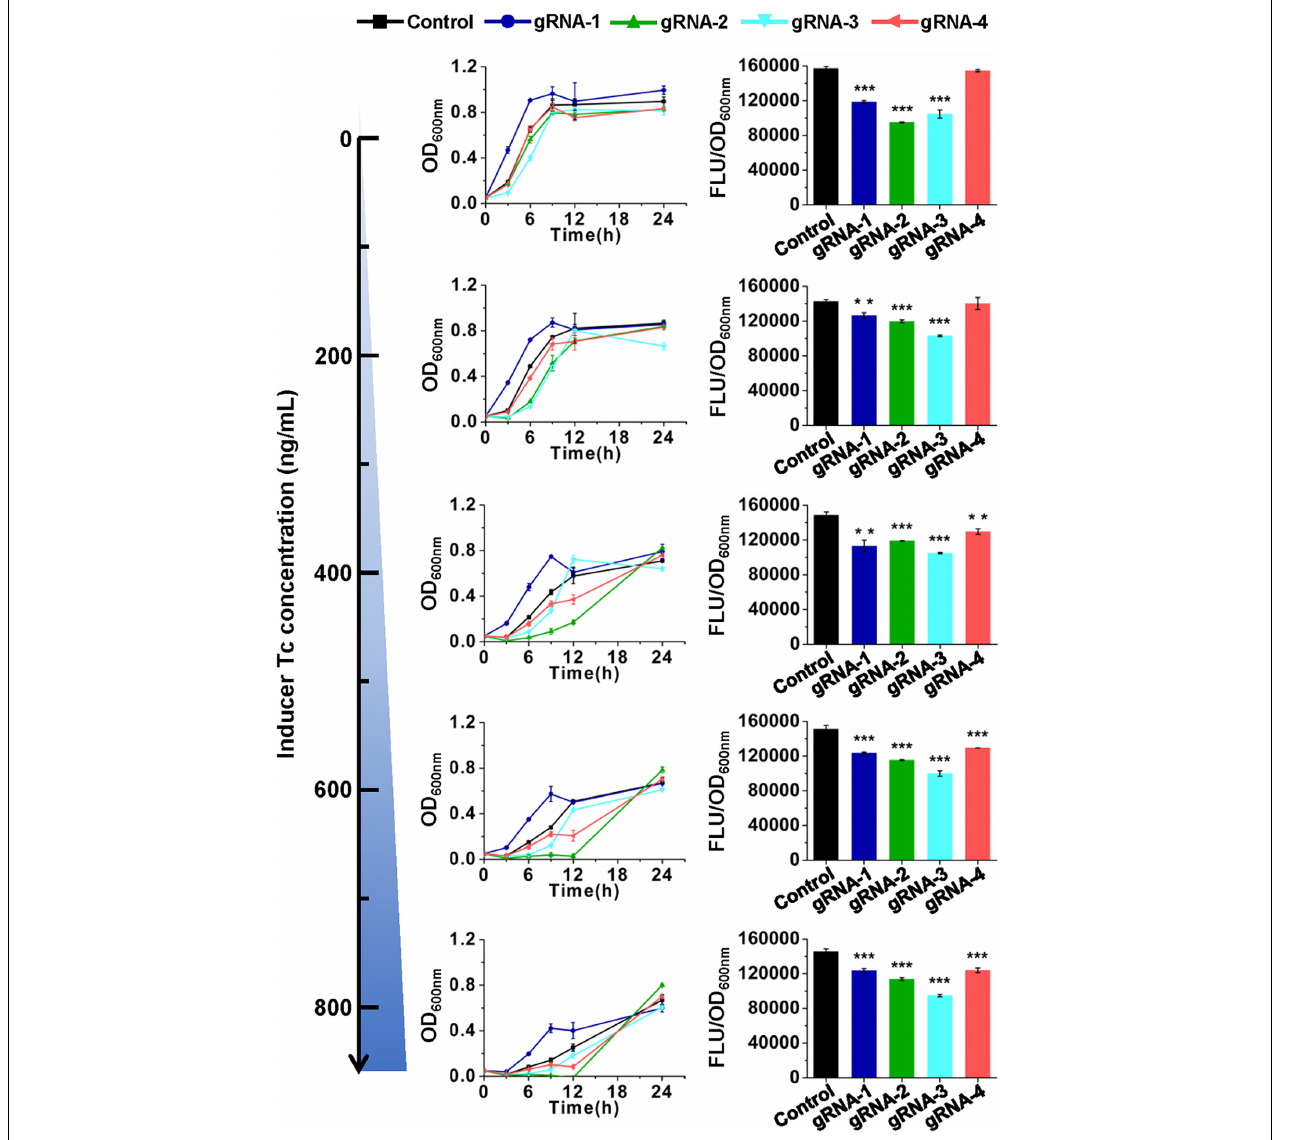
FIGURE 2 | CRISPR/CasRx-mediated gene repression with pre-gRNAs. Design of gRNA-1, gRNA-2, gRNA-3, and gRNA-4 are shown in Figure 1B . The spacer sequences are listed in Supplementary Table S3 . pCasRx-3 and different gRNA expression plasmids were co-transformed into E. coli harboring pGFP for gene repression. Inducer was added at the beginning of cultivation to induce casRx expression. GFP fluorescence and OD 600 nm were determined after 24-h cultivation. Error bars indicate standard deviations from three parallel experiments. All t -tests compare the GFP fluorescence per OD 600 nm using gfp -targeting gRNAs against non-targeting gRNA control (** P < 0.01, *** P <